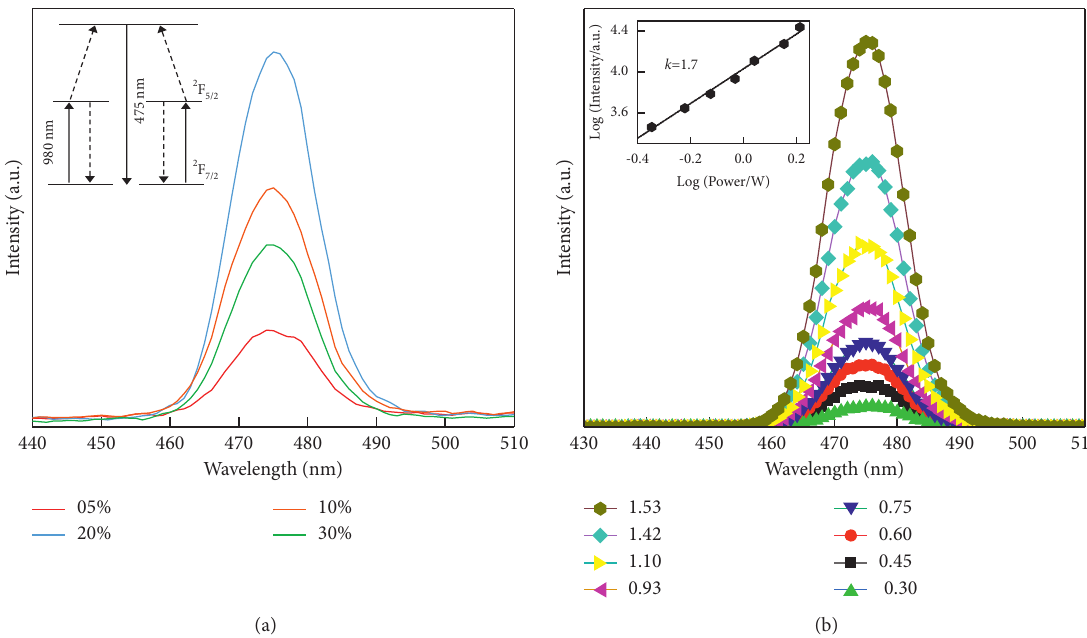
Figure 2: (a) PL spectra of DCNPs upon 980nm excitation at various ytterbium doping concentrations, ranging from 5% to 30%, and inset in the left is a sketch map of cooperative luminescence for Yb 3+ -Yb 3+ pair. (b) PL spectra of DCNPs with different excitation powers, ranging from 0.3W to 1.53W, and inset in the left is the log-log plot of the cooperative luminescence intensities as a function of the pump